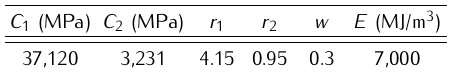
Table 6. Parameters of JWL equation for